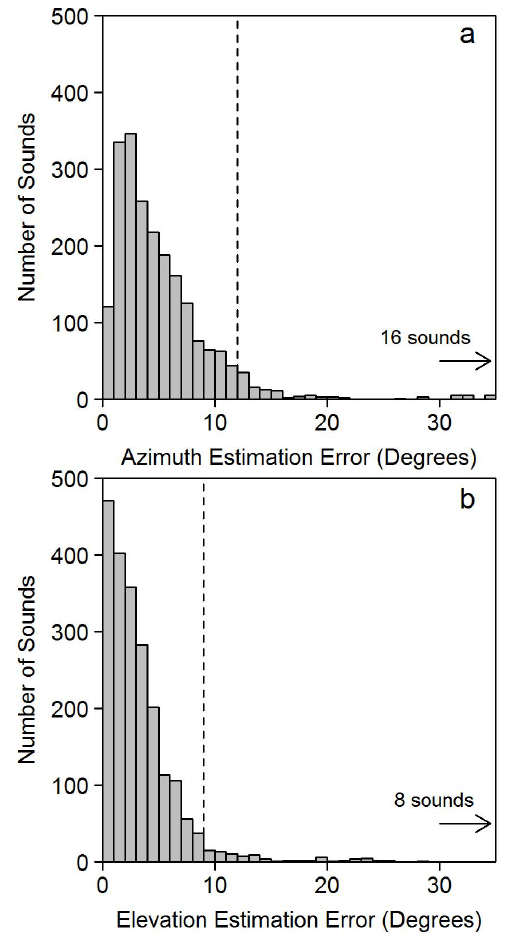
Fig. 5 . Summary of the magnitude of errors in the azimuth (a) and elevation (b) directions across all experiments conducted from varying distances from the microphone (10, 15, 20, 25, or 30 m) and with varying numbers of sources (1, 2, 3, or 4). Numbers at the lower right of each plot indicate the number of sounds with errors greater than 35°. In total, direction-of- arrival was estimated for 2129